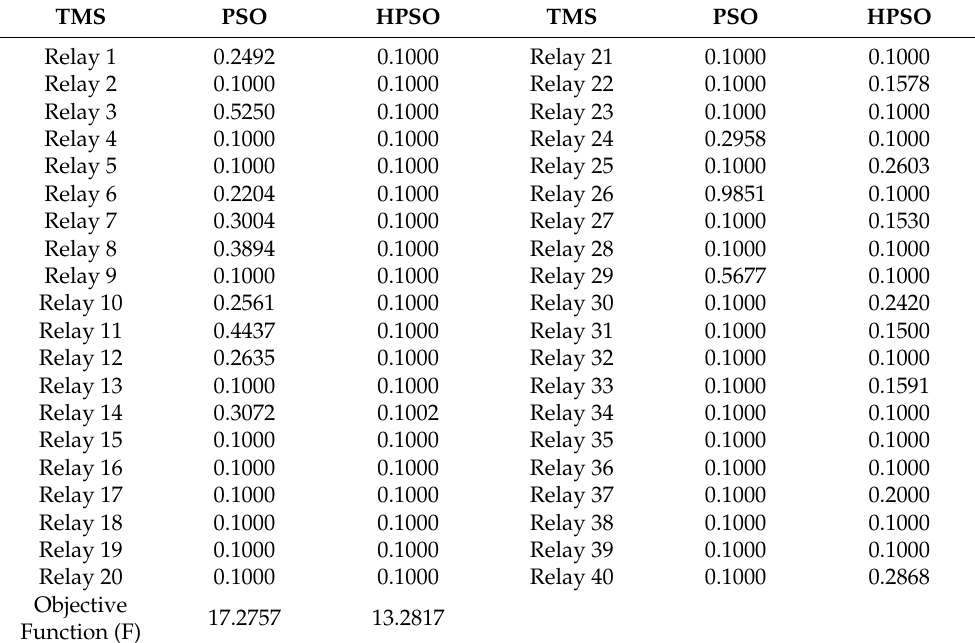
Table 9. Optimized TMS of PSO and HPSO of IEEE 14-Bus system.